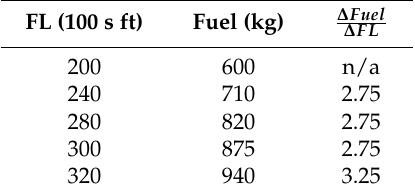
Table 1. Climb fuel cost (extracted from [24]).